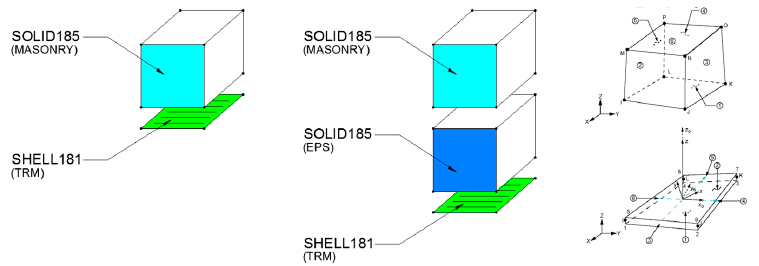
Figure 11. Schematic of the reinforced specimen arrangement using ANSYS SOLID185 and SHELL181 elements.